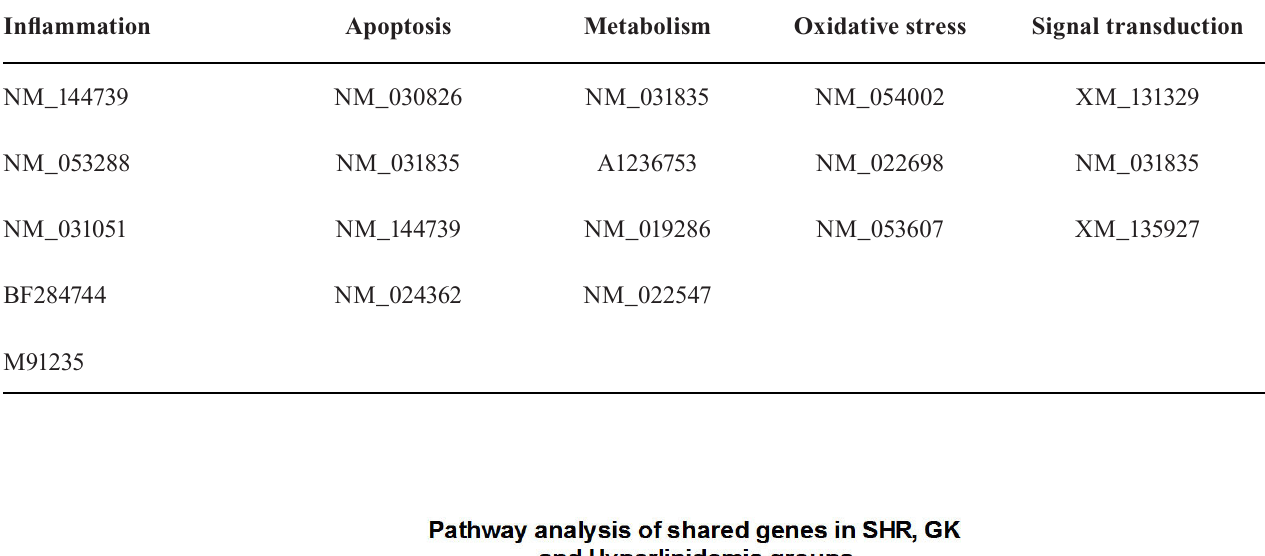
TABLE V- Gene classification based on functions Inflammation